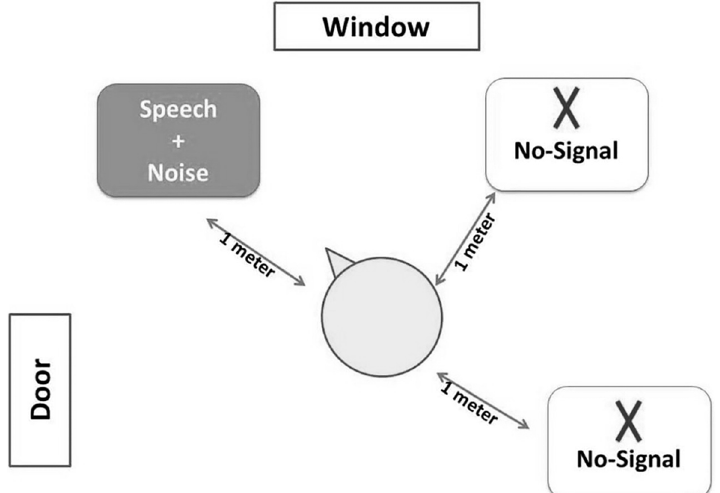
Fig. 1 Signal and noise arrangement in noise 0° azimuth condition